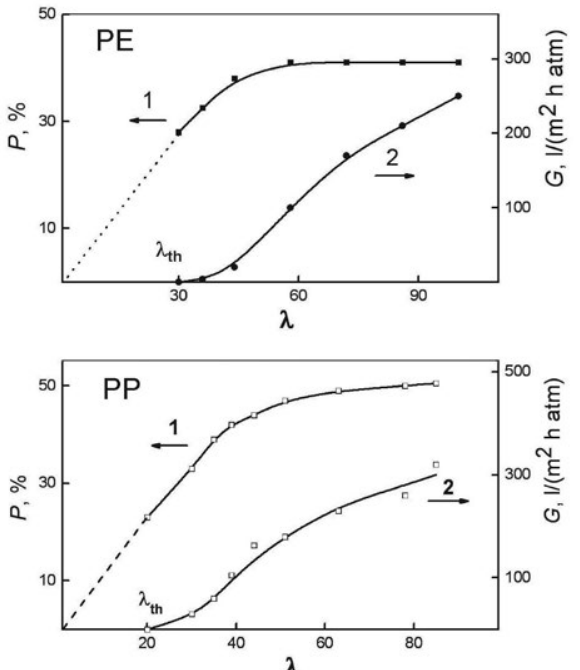
Figure 2. Plots of overall porosity P (1) and permeability G (2) of porous PE and PP films vs. spin draw ratio λ.